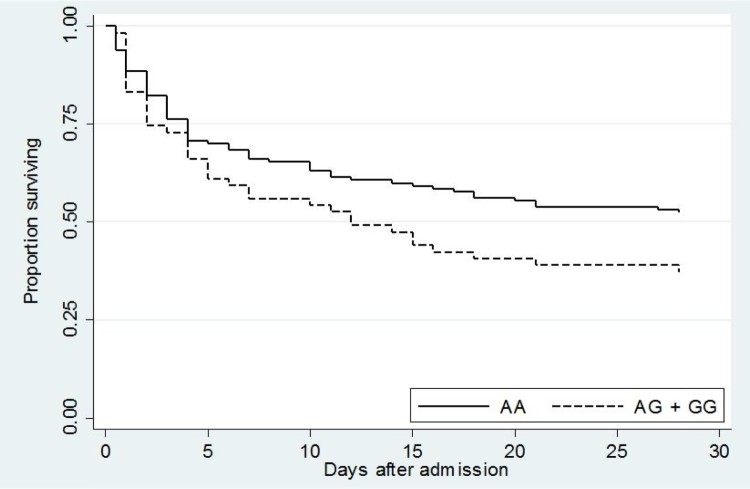
Kaplan–Meier survival curve of validation set subjects demonstrated a trend toward worse survival in carriers of rs76600635 (AG + GG). P = 0.07.